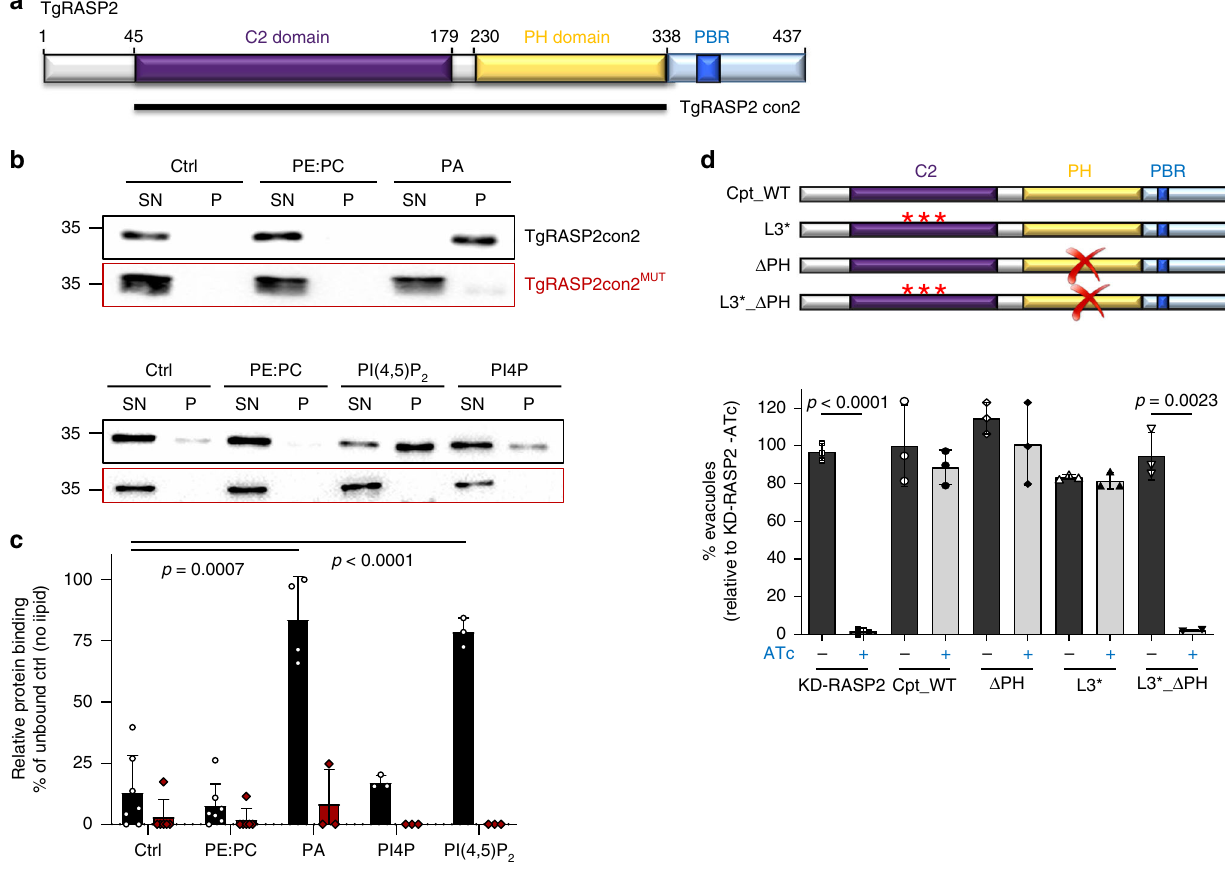
Fig. 7 RASP2 contains lipid binding domains necessary for rhoptry secretion. a Schematic representation of TgRASP2 domains and the TgRASP2con2 recombinant expression construct. b Immunoblots of recombinant TgRASP2con2 and TgRASP2con2 MUT associated or not with liposomes containing phosphatidylethanolamine (PE) and phosphatidylcholine (PC) (proportions 10%: 90%) phosphatidic acid (PA), PE and PC (proportions 30%: 10%: 60%) and phosphatidylinositol-4,5-bisphosphate (PI(4,5)P 2 ), PE and PC (proportions 25%: 10%: 65%). Ctrl, no lipid control; SN, supernatant fraction (unbound); P, pellet fraction (bound protein); Immunoblots were probed with mouse anti-His antibodies. Blots are representative of ≥ three independent experiments. c Quanti fi cation of liposome binding assays. p values generated from Student ’ s t test. Error bars represent ±SD from three or more replicates. d Rhoptry secretion assay with Cpt_WT, Δ PH, L3* and the double mutant Δ PH_L3*. One representative experiment out of three independent assays. Source data are